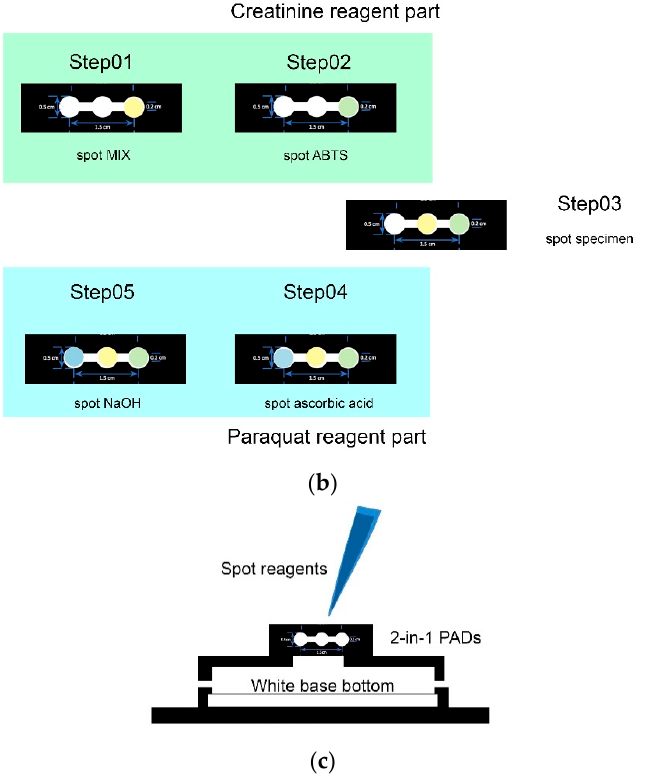
Figure 1. Fabrication steps of 2-in-1 paper-based analytical devices (PADs): ( a ) wax fabrication of 2-in-1 PAD design, ( b ) procedures for spotting reagents onto 2-in-1 PADs; and ( c ) device display.